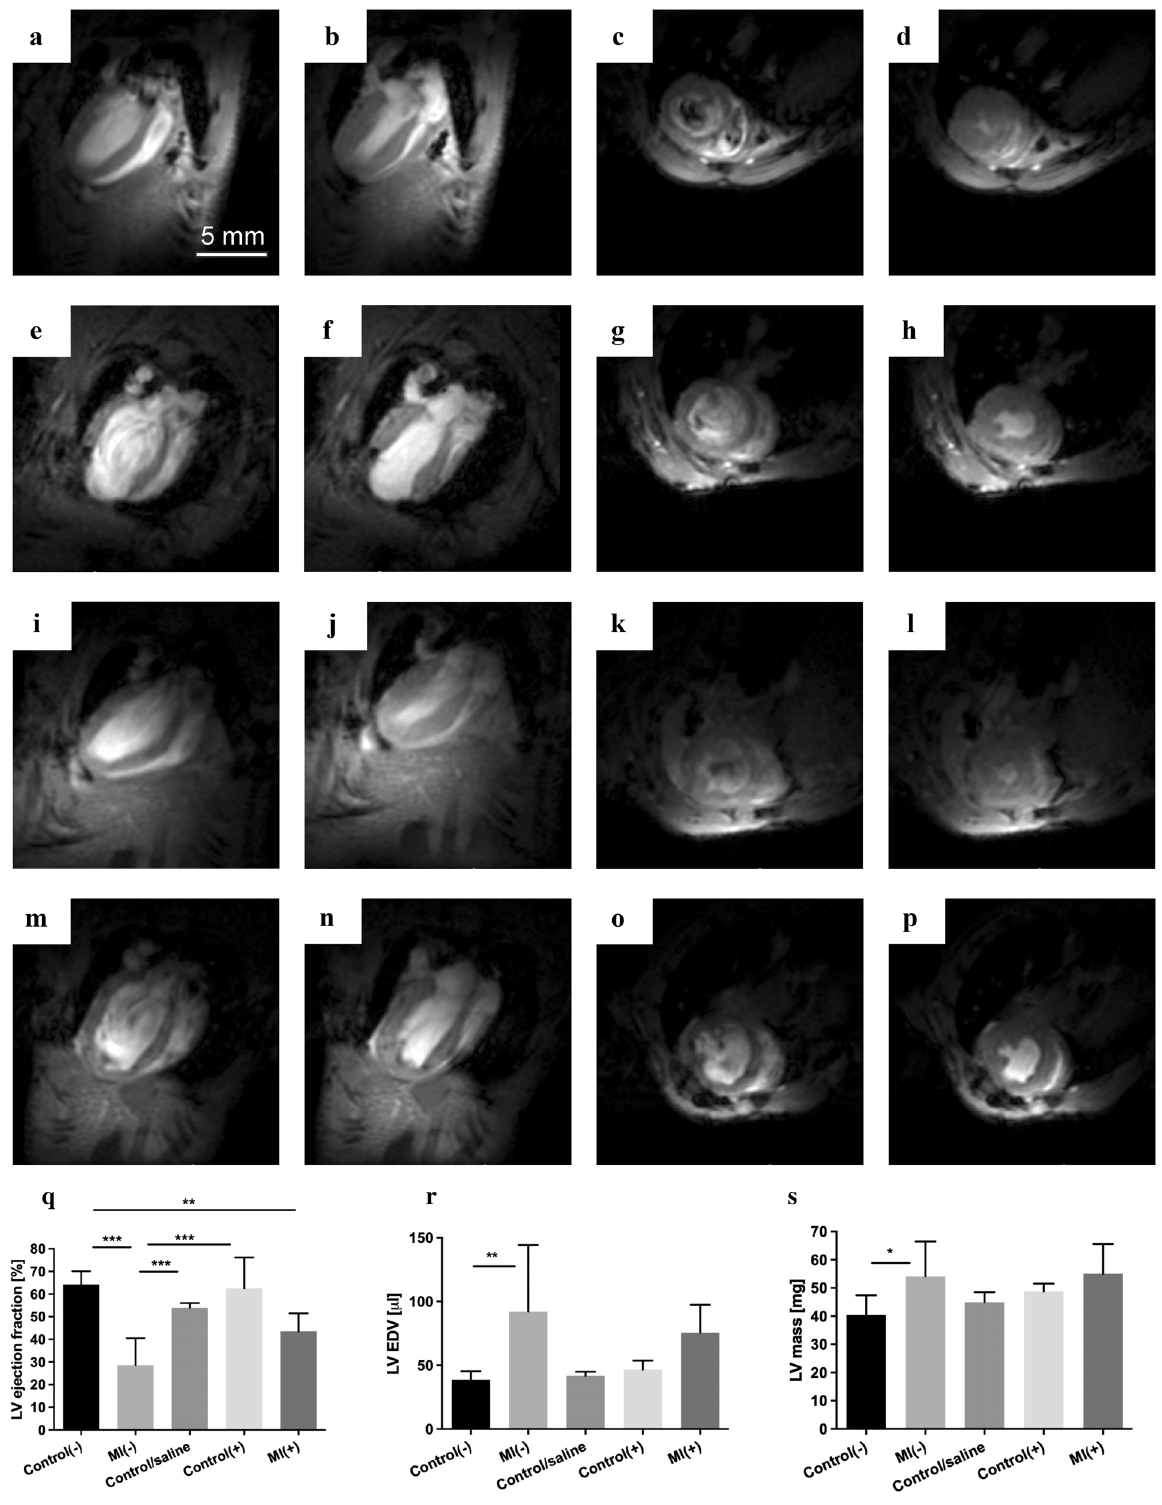
Figure 5. Representative images of end-diastolic and end-systolic volumes from the short and long axes. ( a – d ) control(−), ( e – h ) MI(−), ( i – l ) control(+), and ( m – p ) MI(+) hearts. ( q ) Comparison of LV ejection fraction, ( r ) Comparison of LV EDV volumes, ( s ) Comparison of LV mass. Statistical significance was evaluated with ANOVA and p-values are given as the mean ± SD; *p < 0.05, **p < 0.01, ***p <